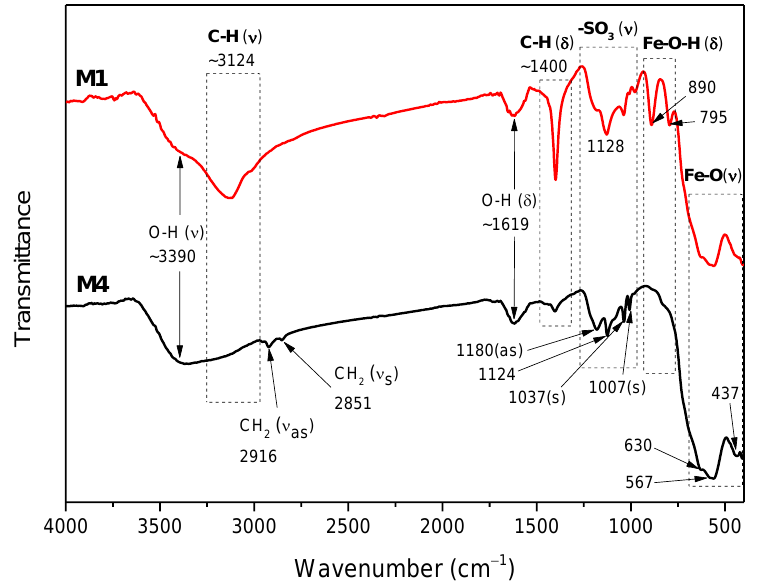
Figure 3. FTIR spectra of the M1 and M4 samples. The peaks positions are indicated in cm −1 . The M2 and M5 IR spectra are presented in Figure 4. Once again, the Fe-O stretching and Fe-O-H bending bands due to the γ -Fe 2 O 3 and α -FeOOH are located at the 410–900 cm − 1 range. C=O stretching band at ~1661 cm − 1 (overlapped with the O-H bending vibration band